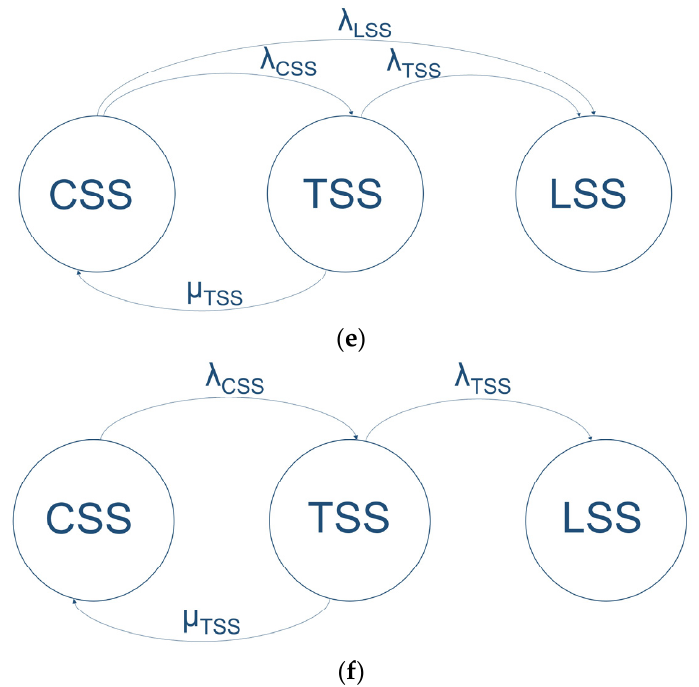
Figure 1. Variants of the possibilities of transitions between the safety states of the WSS (based on the work of [23,37,39]), where CSS is a complete safety state, TSS is a threat to the safety state, and LSS is a loss of safety state. λ is the failure rate and µ is the repair rate, respectively, for each state.